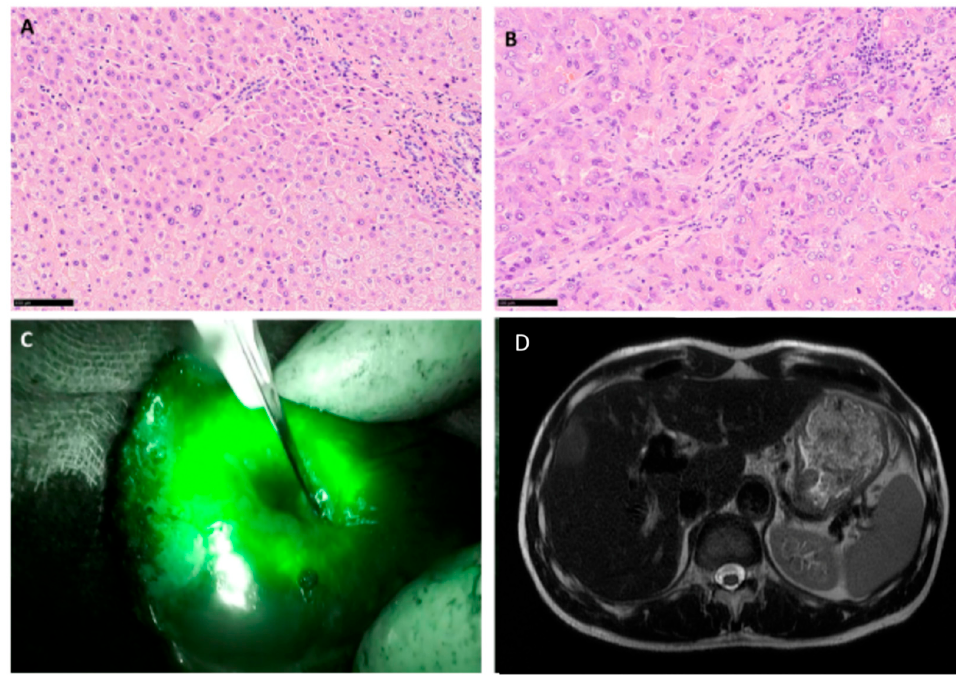
Figure 3. Intra-operative fluorescence imaging and histopathological image of the corresponding area confirming R0 resection. Histological images of tumor free liver tissue in the marginal area with portal fields and a sparse round cell infiltrate ( A ) HE staining, magnification 200×. Histological images of HCC with trabecular and pseudoglandular growth from the same patient ( B ) HE staining, magnification 200×. Intraoperative imaging of the fluorescent tumor after ICG application ( C ), preoperative MRI scan, showing the lesion ( D ).